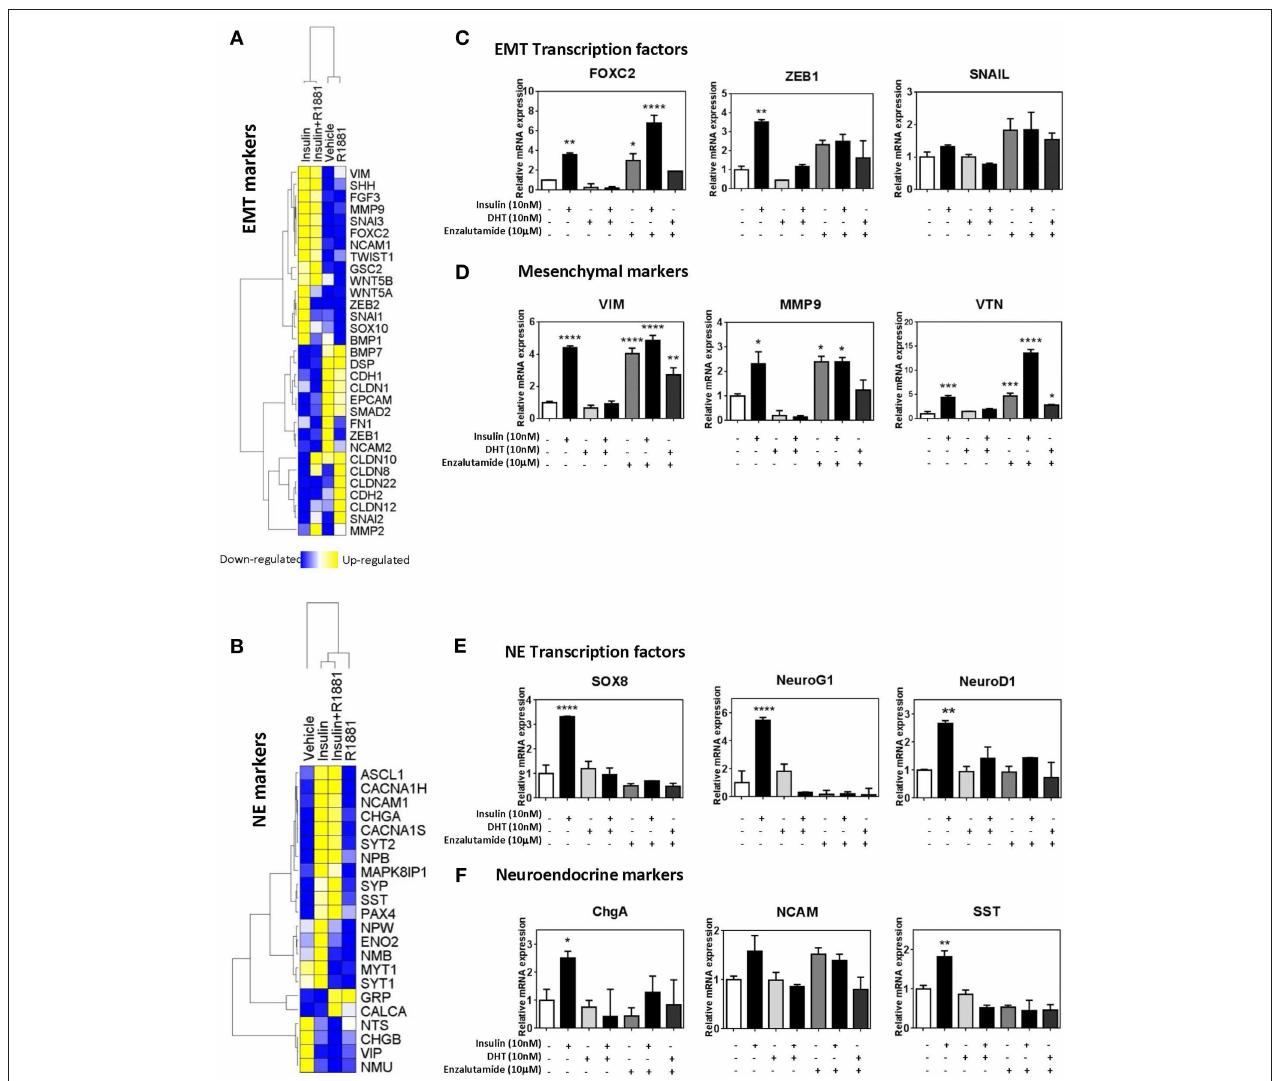
FIGURE 4 | Insulin increases expression of EMT and NE genes in LNCaP cells. Gene expression heatmap of microarray data comparing LNCaP cells treated with 10nM insulin in the presence or absence of 1nM R1881 of typical epithelial and mesenchymal genes (A) and NE genes (B) . qRT-PCR results of LNCaP cells confirm that 48h insulin treatment up-regulated key EMT associated transcriptional factors, FOXC2, ZEB1, and SNAIL (C) , mesenchymal markers, VIM, MMP9 and VTN (D) , NE associated transcriptional factors, SOX8, NeuroG1, and NeuroD1 (E) and NE markers, ChgA, NCAM, SST (F) . 48h insulin treatment (10nM) significantly increased levels of transcription factors in LNCaP cells to levels similar to those observed for enzalutamide (10 µ M) treatment. DHT (10nM) suppressed expression of these transcription factors (All graphs n = 3, * p < 0.05, ** p < 0.01, *** p < 0.001, **** p < 0.0001, One-way ANOVA, ± SEM with vehicle as